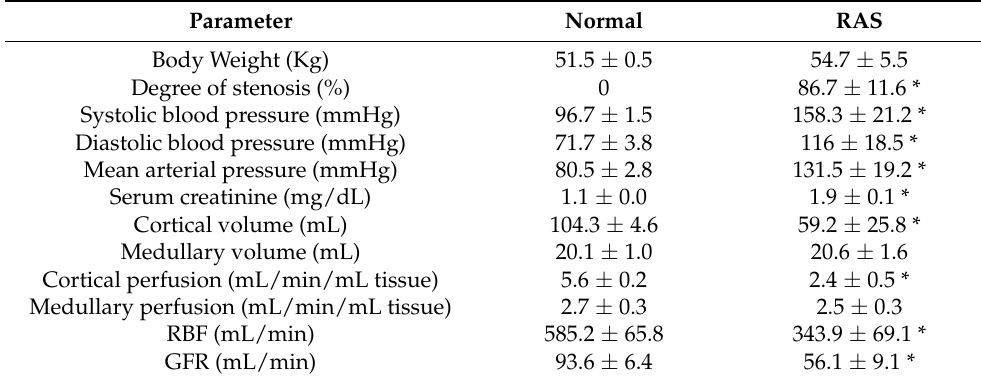
Table 1. Systemic characteristic of normal and renal artery stenosis (RAS) pigs ( n = 3 each) at 10 weeks.